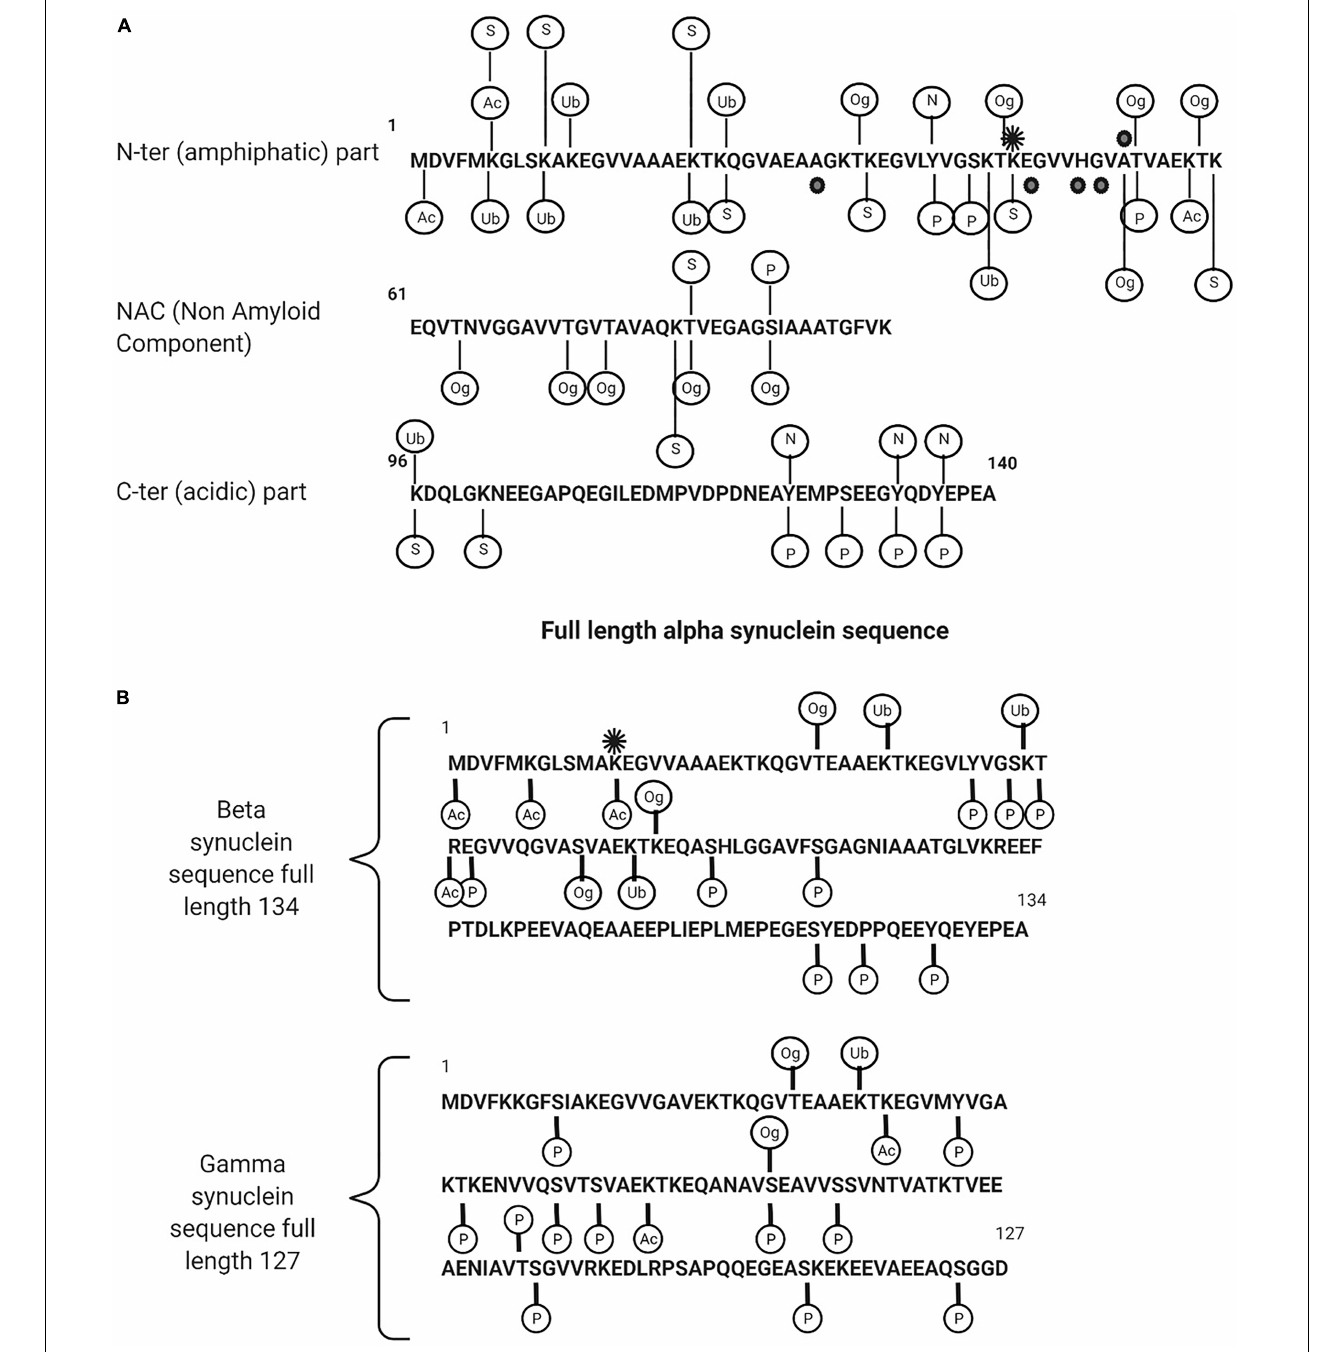
FIGURE 2 | (A) Description of alpha synuclein post translational modifications. (B) Beta and gamma synuclein post translational modifications. Ac, acetylated; Ub, ubiquitination; Og, O-glyNaction; N, nitration; P, phosphorylated; S, SUMOYLATION. The black points are the point of mutations (in familial form of the PD) and the black star is methylation